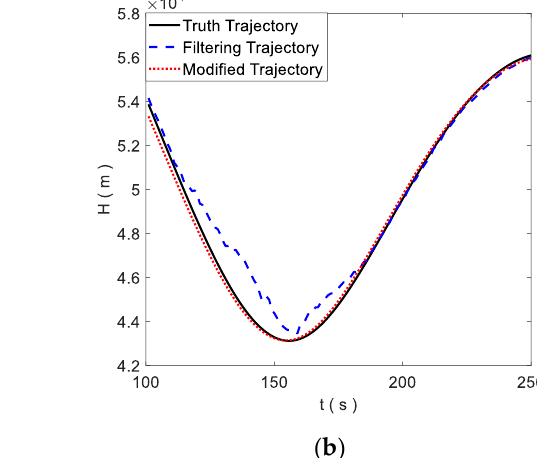
Figure 12. Effect of parameter modification network: (a) is the filtering result of the observed con- trol parameters; (b) is the modification result of the filtering control parameters; (c) is the prediction result of the control parameters values.